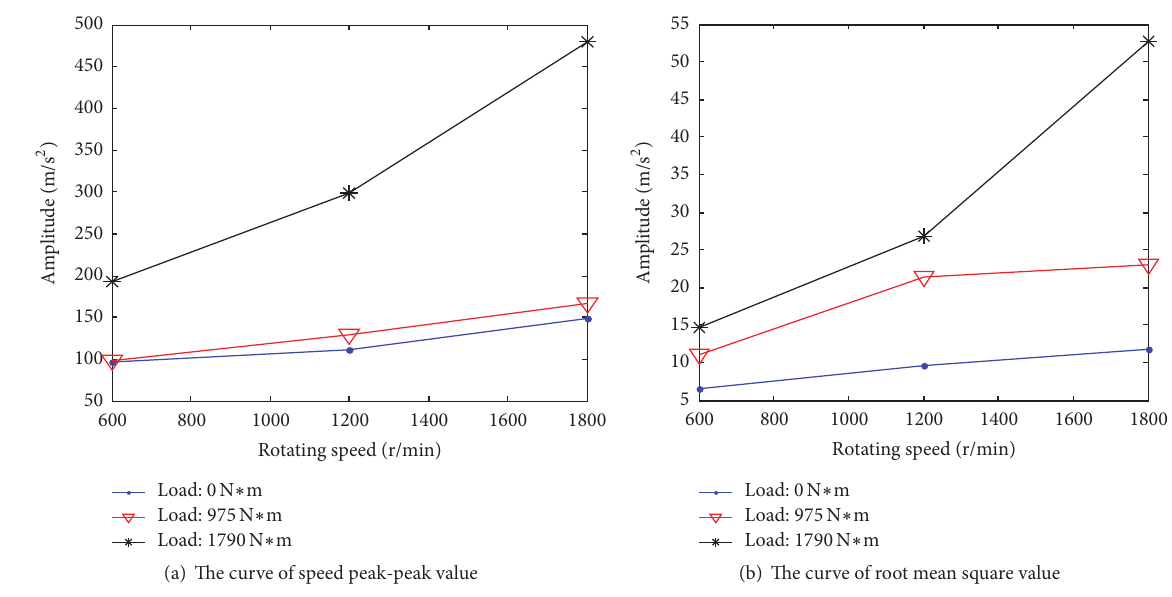
Figure 6: Broken teeth-pitting compound fault